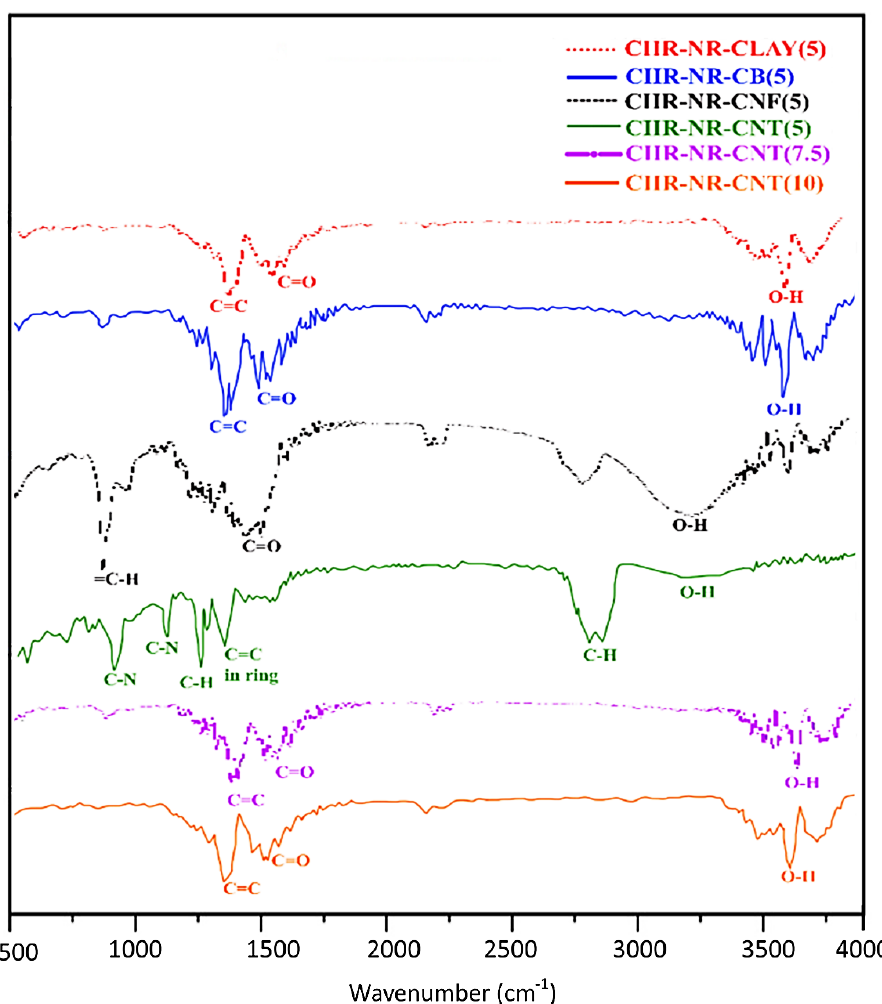
Figure 6. FTIR image of CIIR-NR blend nanocomposite with different fillers CNT/CNF/CB/CLAY with different concentrations.